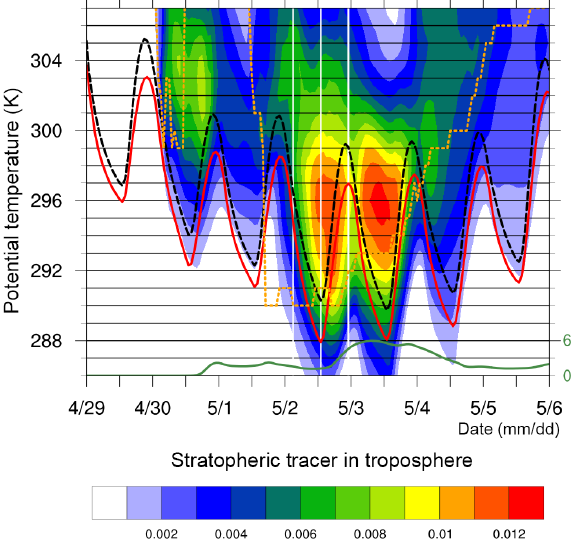
Figure 7. Time series for the North American STT event from 29 April to 6 May 2006 of the stratospheric tracer concentration (colours; averaged over all tropospheric grid points in the target region polygon shown in Fig. 2a on several isentropic surfaces), the surface height (solid red line, averaged over target region), the height of the top of the boundary layer (dashed black line, aver- aged also over the target region) and the lowest potential temper- ature value of the tropopause in the target region (dashed orange line). The green line indicates the averaged stratospheric tracer con- centration in the target region on the lowest model level. The value of 6 corresponds to 0.6%. The white vertical lines denote the times shown in Figs. 3 and 4.